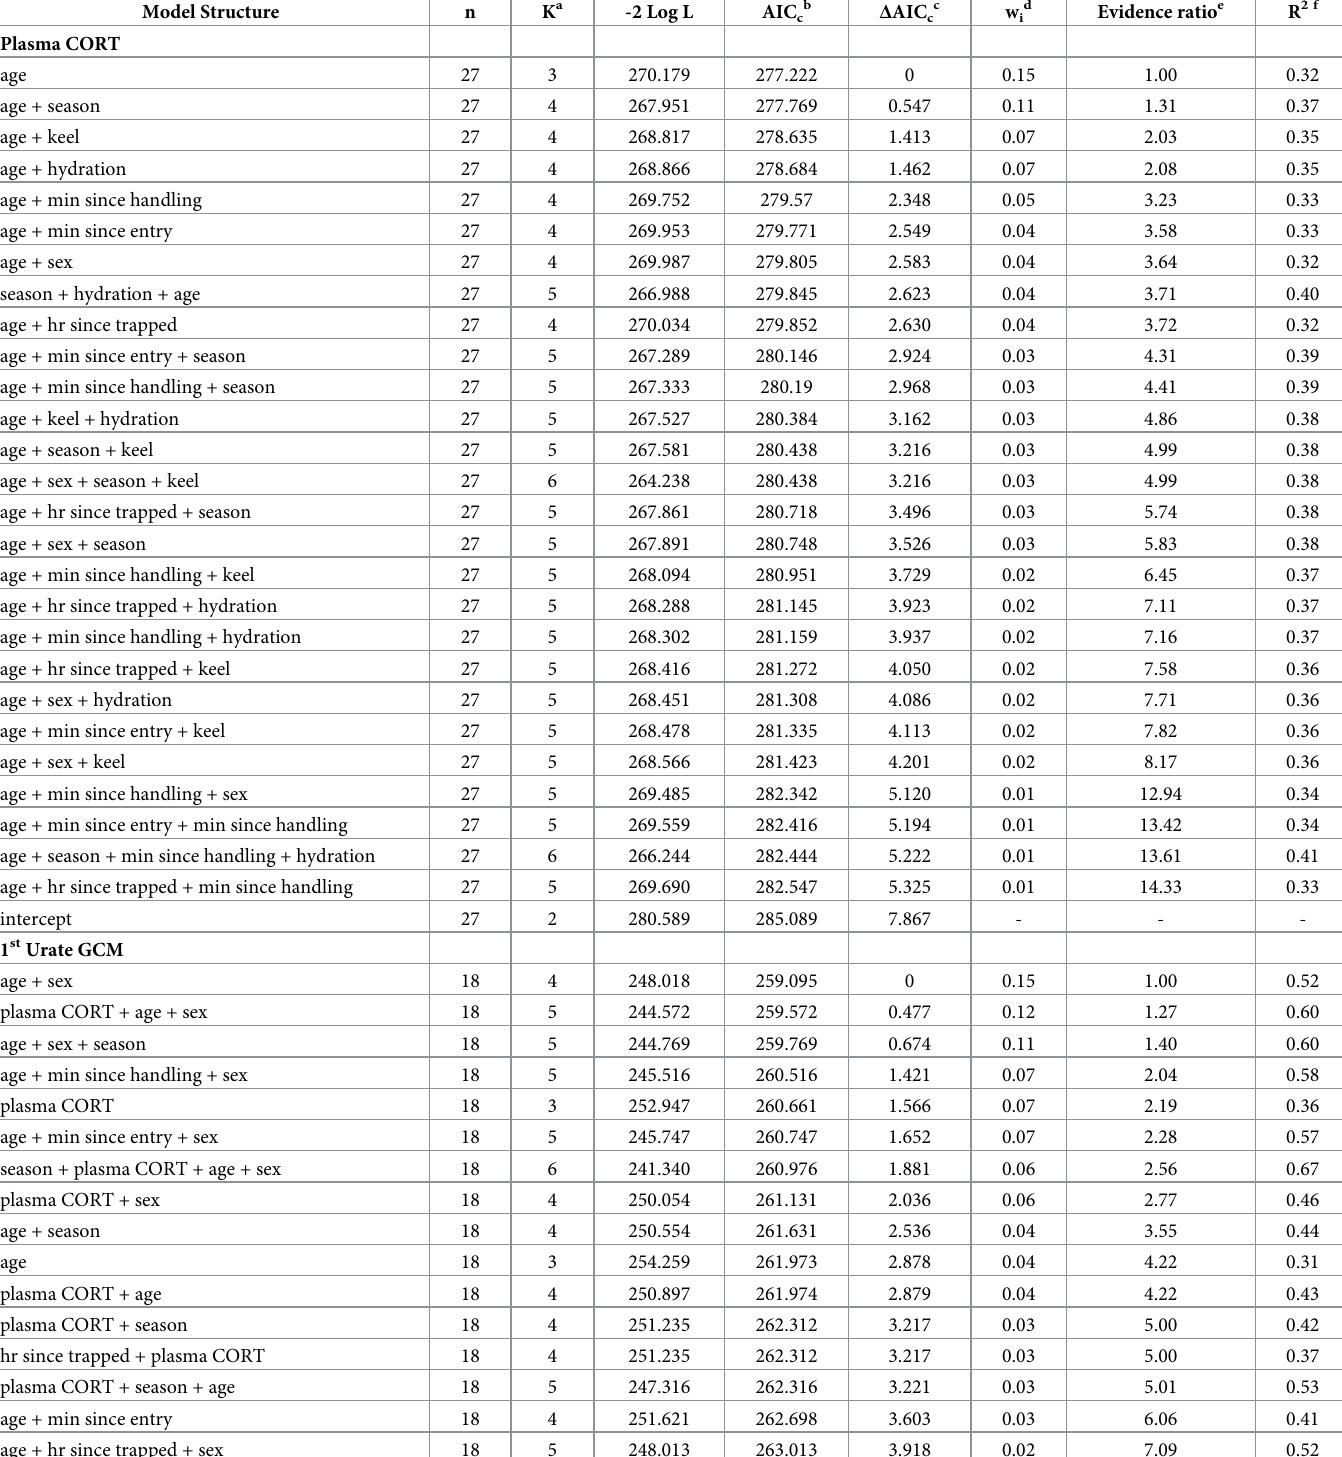
Table 2. Ranking of candidate multiple linear regression models describing variation in plasma corticosterone (CORT) concentrations and glucocorticoid metabo- lite (GCM) concentration of first collected urates in California condors. Within sample type, the subset of models accounting for 90% of AIC weight and the null model (intercept) are